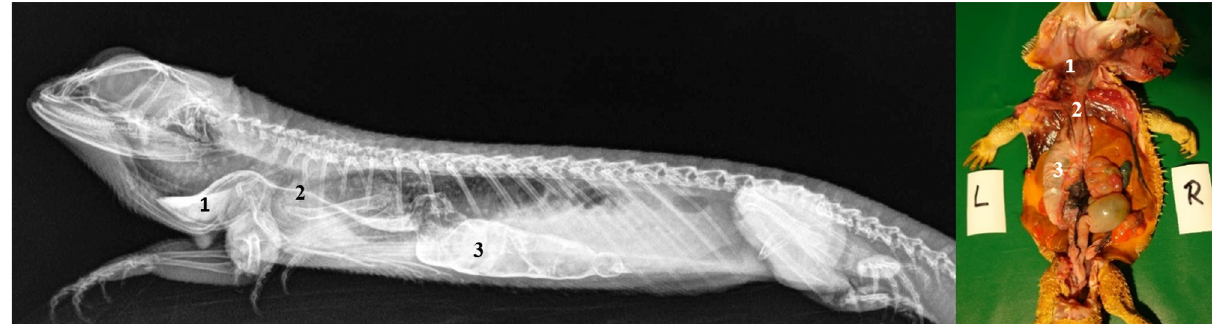
Fig 9. Laterolateral (LL) radiograph in ventral recumbency and using a horizontal beam. 15 minutes after oral administration of BaSO 4 , (kV 42, mAs 2). Note the BaSO 4 in the esophagus in the ventrally dependent gular area (1), distal esophagus (2), and stomach (3).